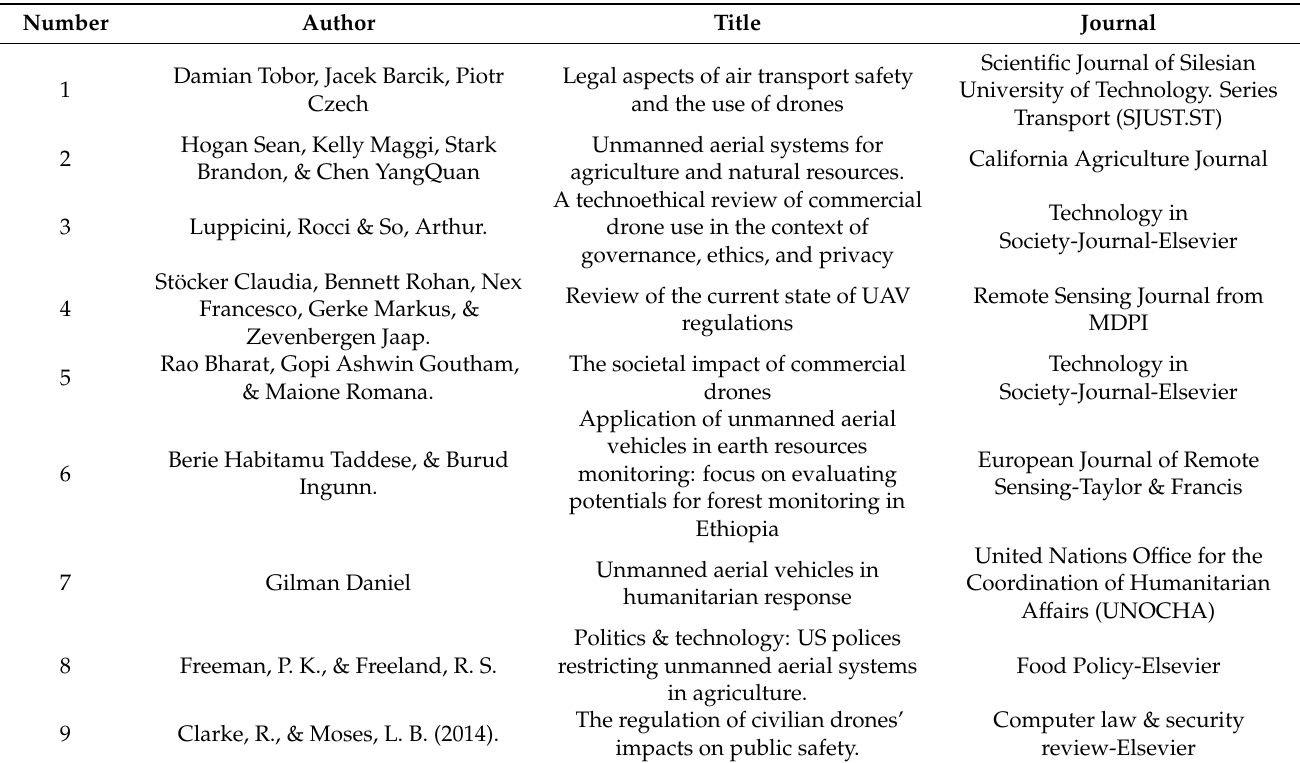
Table 5. Summary of included